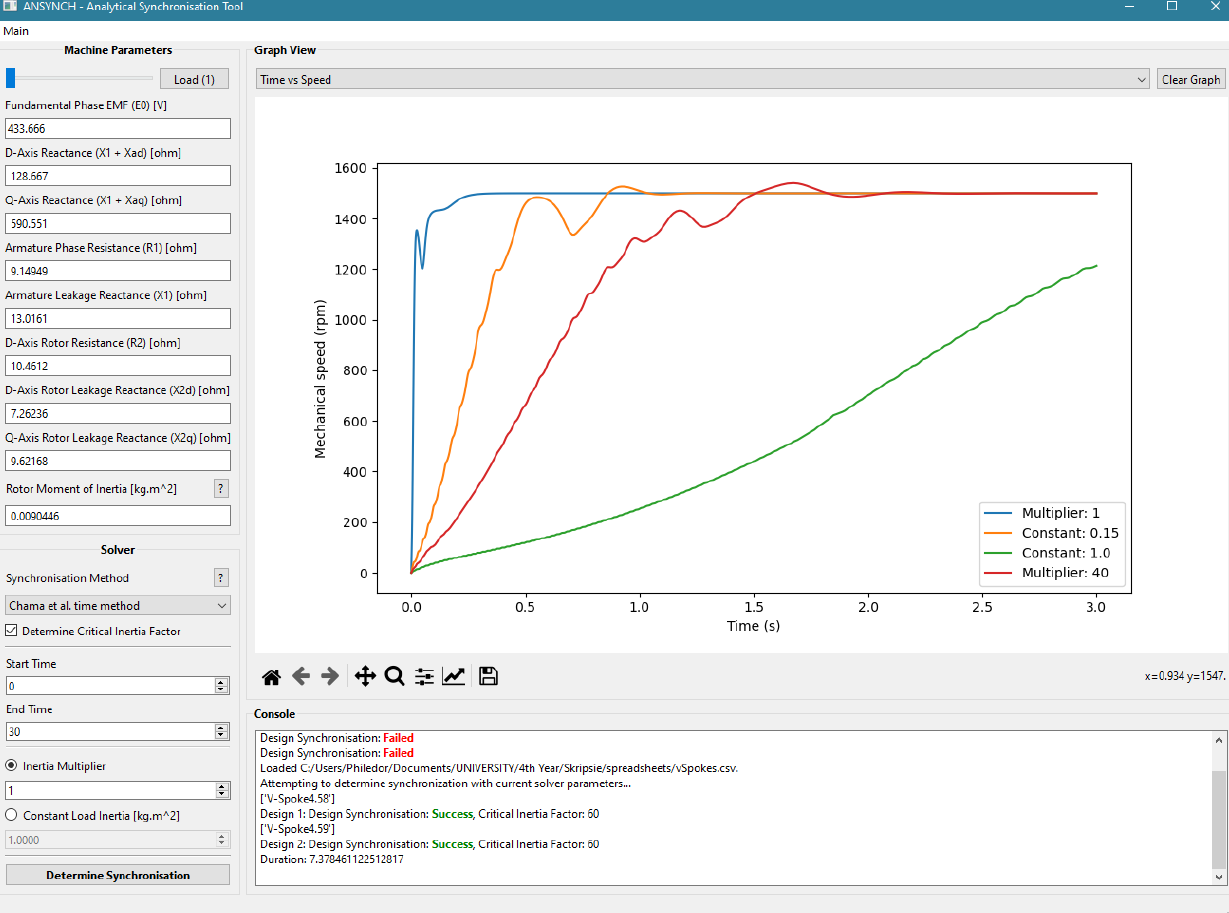
Figure 21. Final GUI layout of analytical synchronization